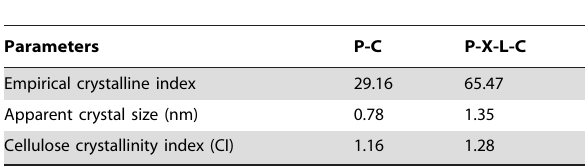
Table 3. The crystallinity index and apparent crystal size (ACS) of untreated (P-C) and treated (P-X-L-C) ONP pulp cellulose.